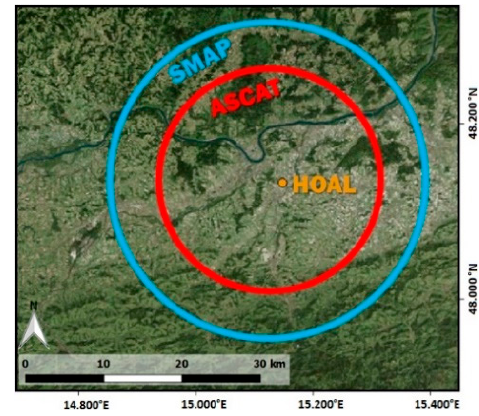
Figure 2. Schematic overview of the sensor footprints of advanced scatterometer (ASCAT) and soil moisture active passive (SMAP) over the study area (hydrological open air laboratory (HOAL)). Map data © 2019 Bing.